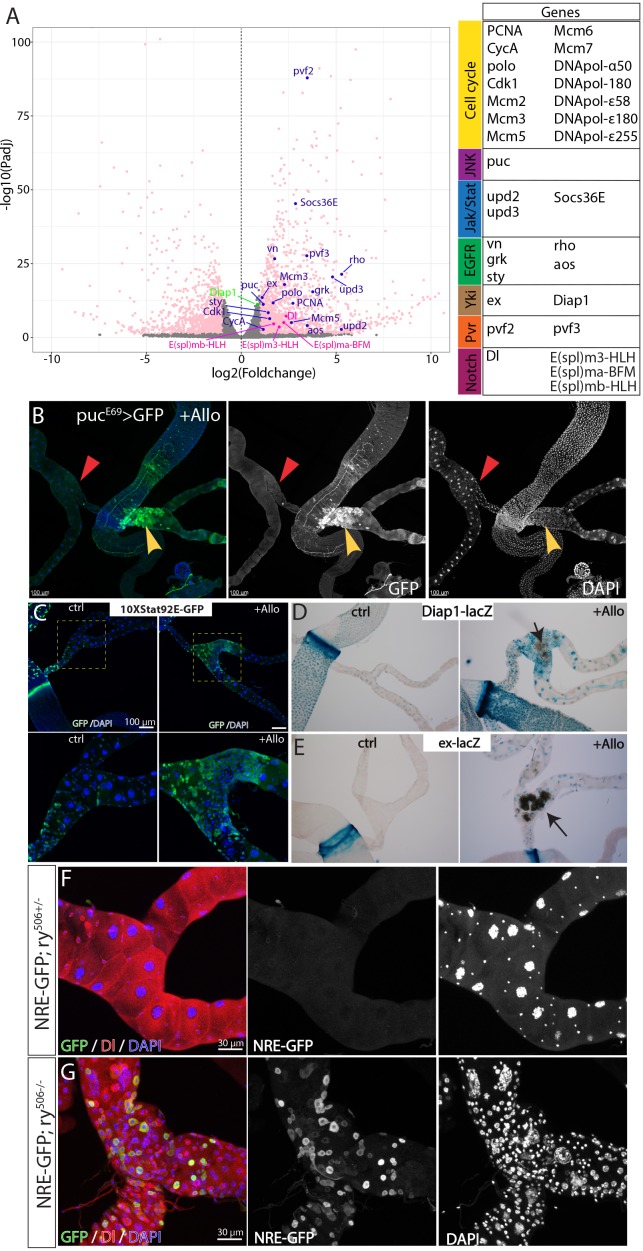
Stone-induced damage causes activation of multiple proliferation pathways.(A) Volcano plot showing differentially expressed genes between ry mutant lower tubules carrying stones and wild-type lower tubules. Genes with fold change more than two and Padj <0.05 are in pink. The table on the right shows the pathways that the highlighted genes are involved in the volcano plot. (B) Expression of pucE69-Gal4 > GFP in one pair of Malpighian tubules carrying stones (denoted by yellow arrowhead) and the other pair of Malpighian tubules without stones (red triangle) from the same animal after allopurinol treatment. (C) Expression of Jak/Stat pathway reporter, 10XStat92E-GFP in control Malpighian tubules (left panels) and in Malpighian tubules carrying stones induced by allopurinol (right panels). (D–E) X-gal staining showing the expression of Diap1-lacZ (D) and ex-lacZ (E) in normal and stone-carrying Malpighian tubules. Both Diap1-lacZ and ex-lacZ are widely used reporters for Yki activity. (F–G) Expression of Notch signaling reporter, NRE-GFP in ry+/- Malpighian tubules (F) and in ry506 Malpighian tubules bearing stones.